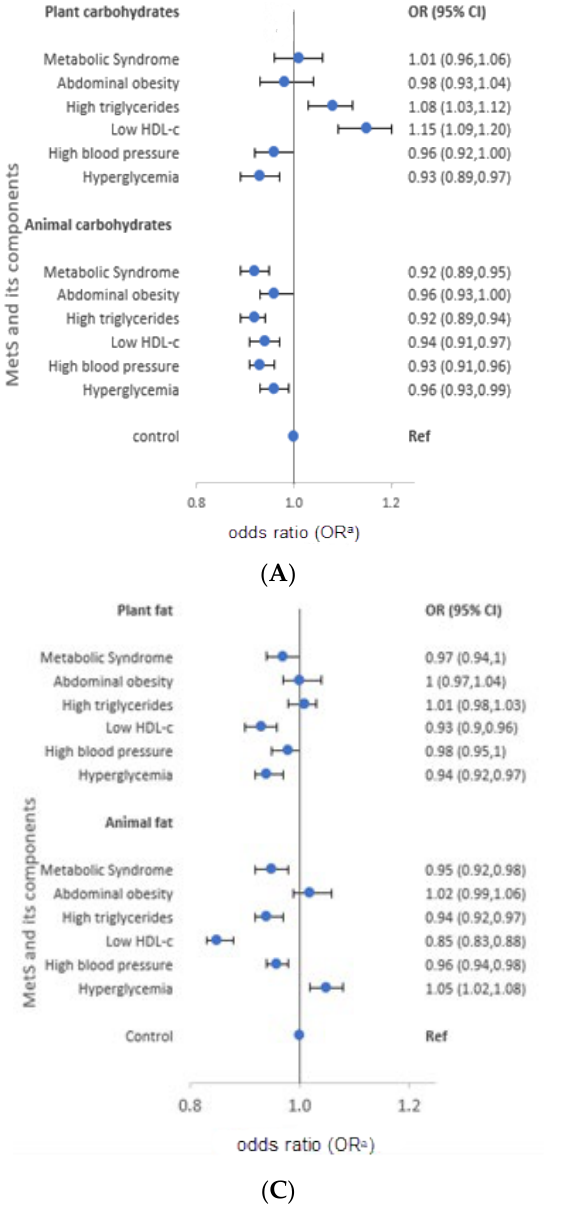
Figure 2. Odds ratios (OR) and 95% confidence intervals (CI) of metabolic syndrome and its components stratified by source of macronutrients in men, the HEXA-G study, 2004–2013. ( A ) plant and animal-source carbohydrates ( B ) plant and animal-source proteins ( C ) plant and animal source fats. HDL-c: High density lipoprotein cholesterol. a Adjusted for age, body mass index, marital status, education, family income, occupation, smoking, drinking, regular exercise, and energy intake.